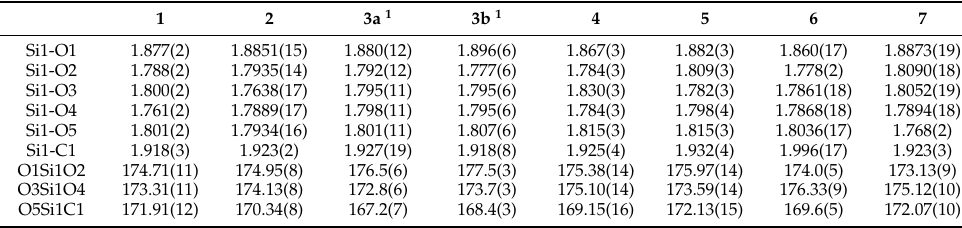
coordination with potassium cation (in 6 and 7 ). Thus, [Si IV L Cat x 2 ] − proved to be a rigid, very stable cage system almost insensitive to the influence of the nature of a ligand and intermolecular interactions. Table 1. Selected geometrical parameters (Å, º) of SiCO 5 polyhedra in 1 – 7 .